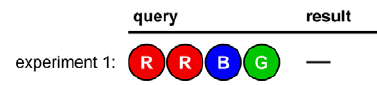
Figure 5. A game opening illustrating Lesson 3.